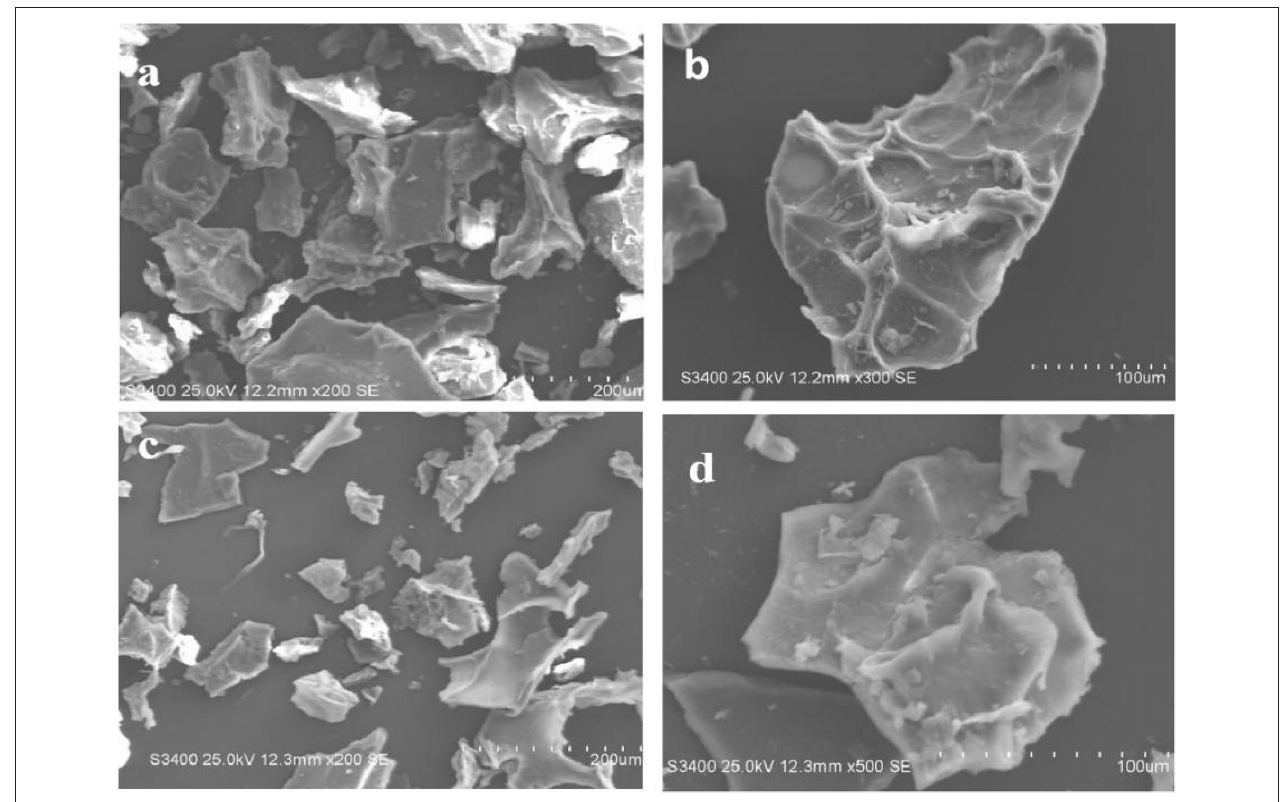
FIGURE 2 | Microstructure of ACA-DK and ACA-DF observed by scanning electron micrographs (magnifications: 200X, 100X, respectively). (a,b) SEM image of ACA-DK; (c,d) SEM image of